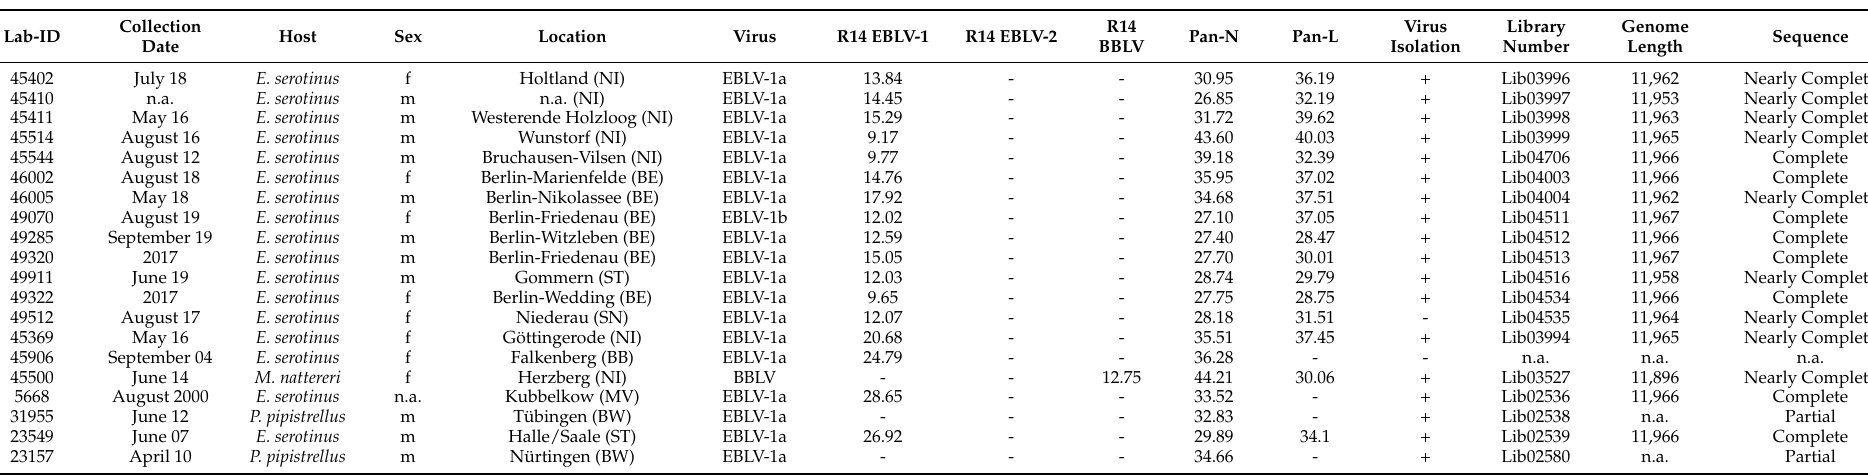
Table 2. Details for bat samples that tested positive for EBLV-1 and BBLV. Cq-Values for the different RT-PCR assays are provided. For sample 45906, NGS only generated two viral reads and the lyssavirus species was determined with PanLyssavirus hn-RT-PCR [32] and subsequent Sanger sequencing. Abbreviations for German federal states: Baden-Wuerttemberg (BW), Berlin (BE), Brandenburg (BB), Lower Saxony (NI), Mecklenburg-Western Pomerania (MV), Saxony-Anhalt (ST), Saxony